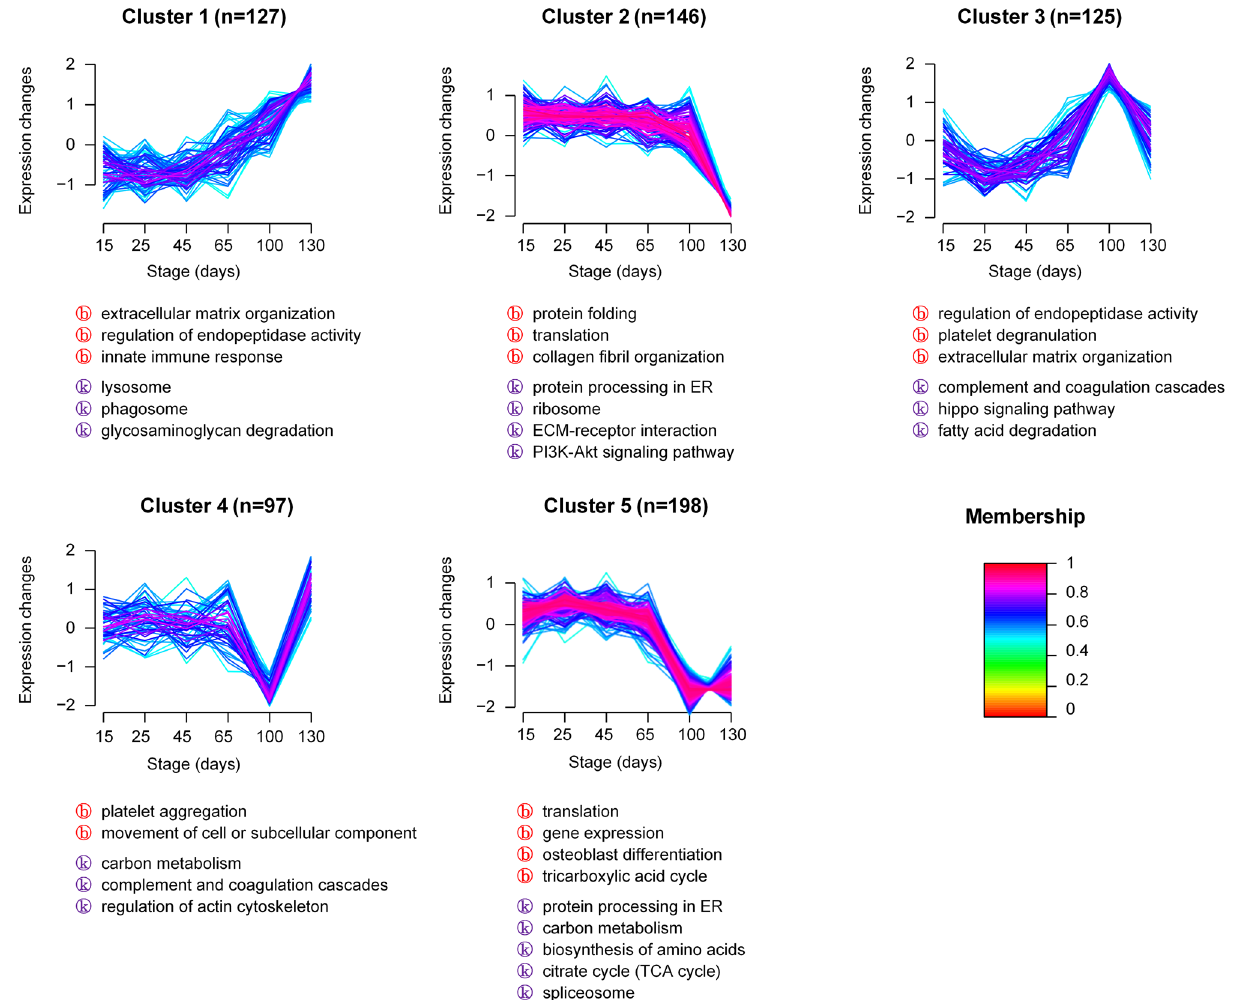
Figure 6. Global dynamics of proteins during antler development. The main function class was searched for GO (Biological process) and KEGG